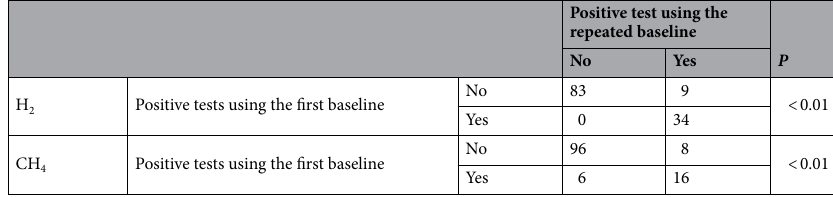
Table 3. Performance of breath tests with baseline re-sampling. Tests were classified according to the presence of an increase in H 2 or CH 4 levels after stimulus intake, depending on whether first baseline of repeated baseline were considered for delta calculations. Increase in H 2 levels was considered when ≥20 ppm and in CH 4 levels when ≥10 ppm.